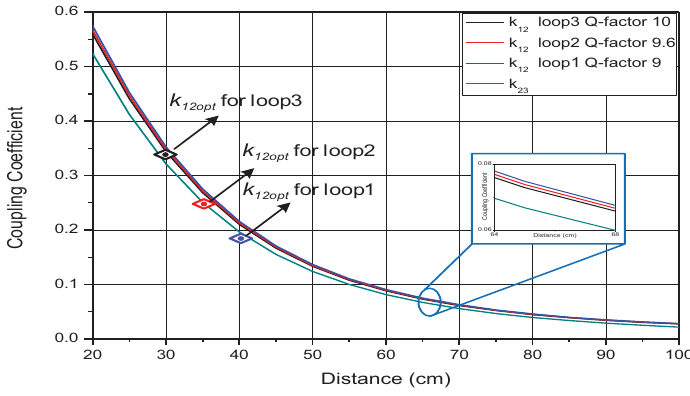
Figure 4. Computed k 12 opt for the Case 1 system for three different loops and k 23 for varying d 23 . The obtained k 12 for different loops are indicated with three